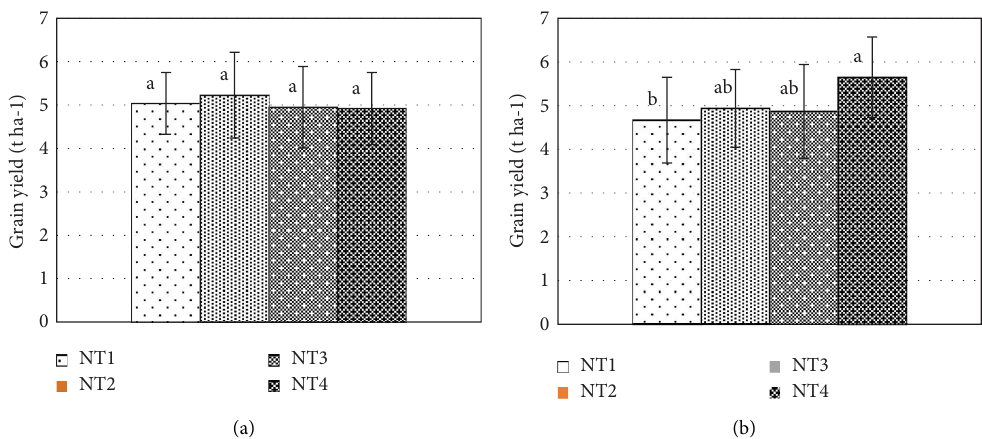
Figure 1: Sugarcane flter cakes fertilization on rice yield at diferent treatments and cropping season. (a) Summer-autumn; (b) autumn- winter. Note: a, b mean signifcant diferences according to the treatment ( p < 0 . 05); ns: no meaningful diference. Te standard deviation in the vertical bar and columns with the same letter are not signifcantly diferent at 5%. Table 4: Some chemical properties of rice soil before and after the experiment in the Cho Moi district. Experiment/criteria pH H2O 1 :2.5